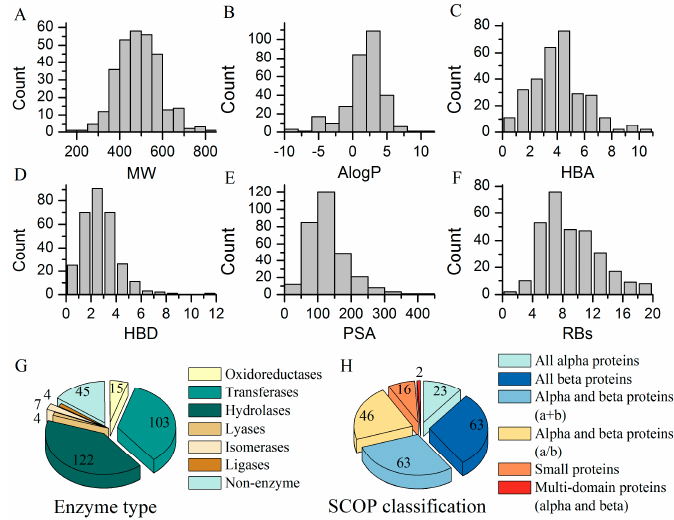
Figure 1. Physicochemical properties of BRCD-3D (3D Biologically-relevant Representative Compound Database) ligands and classifications of their corresponding targets. ( A – F ) Properties distribution of the ligands, calculated by Pipeline Pilot 8.5. MW: molecular weight; AlogP: the octanol-water partition coefficient; HBAs: the count of hydrogen bond acceptors; HBDs: the count of hydrogen bond donors; PSA: polar surface area; RBs: the number of rotatable bonds; ( G ) Pie chart of the enzyme types of the targets. Details are shown in Supplementary Materials Table S3; ( H ) Pie chart of the SCOP classification of the targets. Entries without SCOP annotations are not taken into account. Details are shown